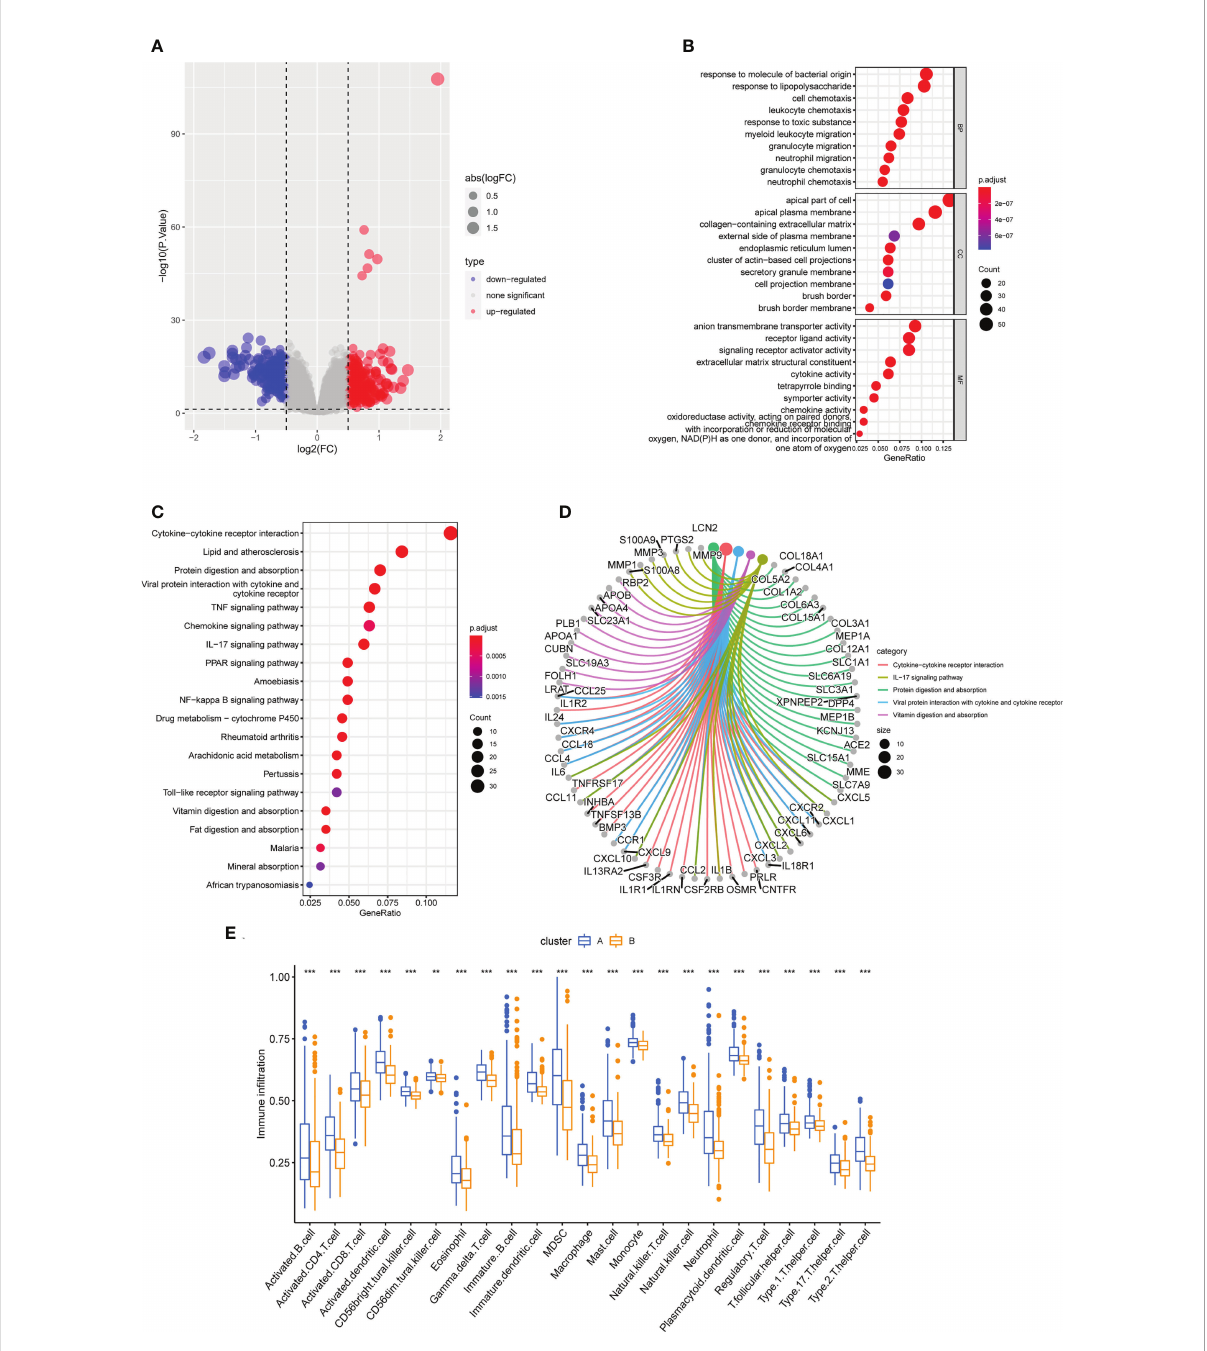
FIGURE 10 Functional enrichment analysis and immune cell in fi ltration between cuproptosis subtypes. (A) The volcano plot of DEGs. (B) Enriched items in GO analysis. (C, D) Enriched items in KEGG pathway analysis. (E) Correlation matrix of all 23 immune cell subtype compositions. ** represents p < 0.01; *** represents p <